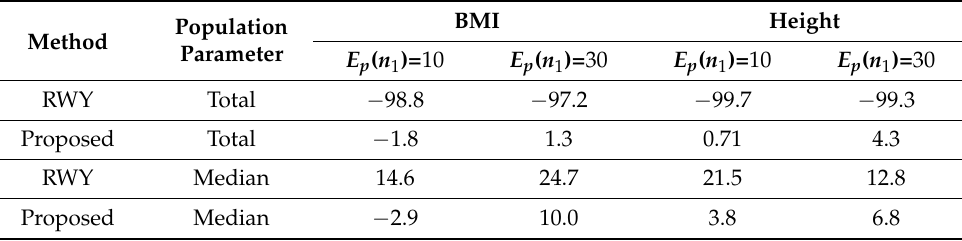
Table 4. The percent relative biases of the bootstrap variance estimators.